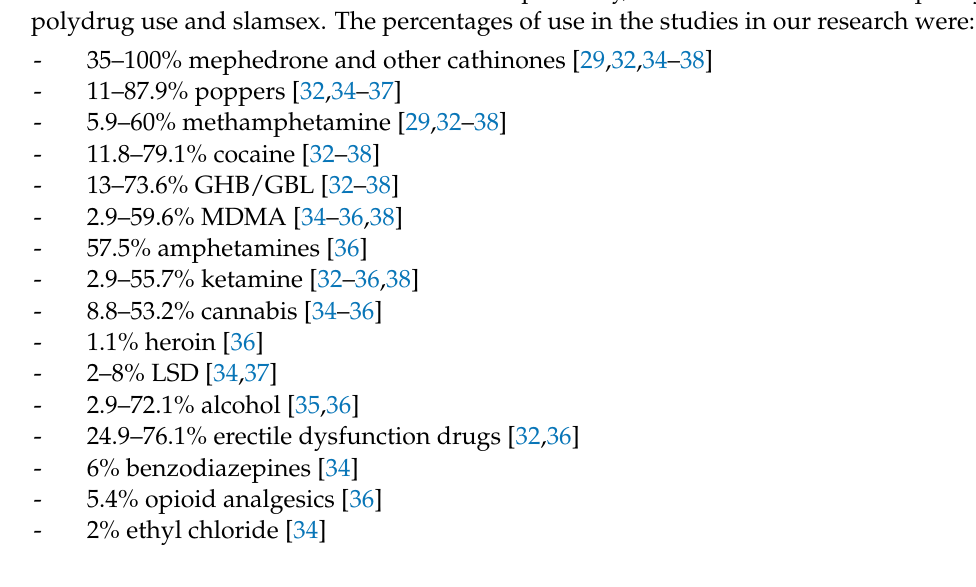
Table 5. Slamsex and polydrug